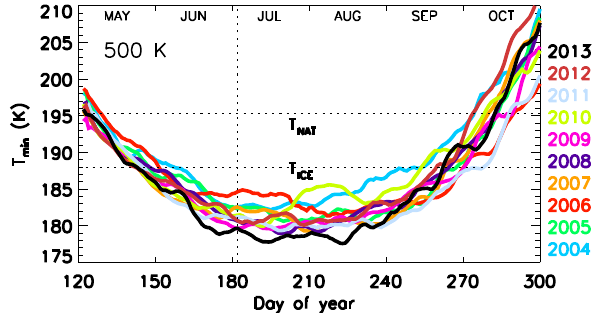
Figure 2. Evolution of polar cap (50–90 ◦ S) minimum tempera- ture derived from the ECMWF operational analyses for each winter from 2004 to 2013 at 500K ( ∼ 19km) potential temperature. The T NAT and T ICE thresholds are also